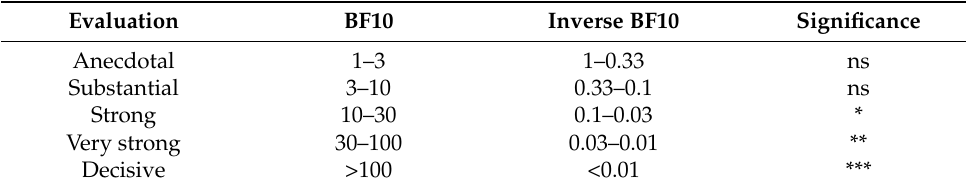
Table 2. BF10, inverse BF10 [24] and arbitrary significance asterisks, inserted by authors.